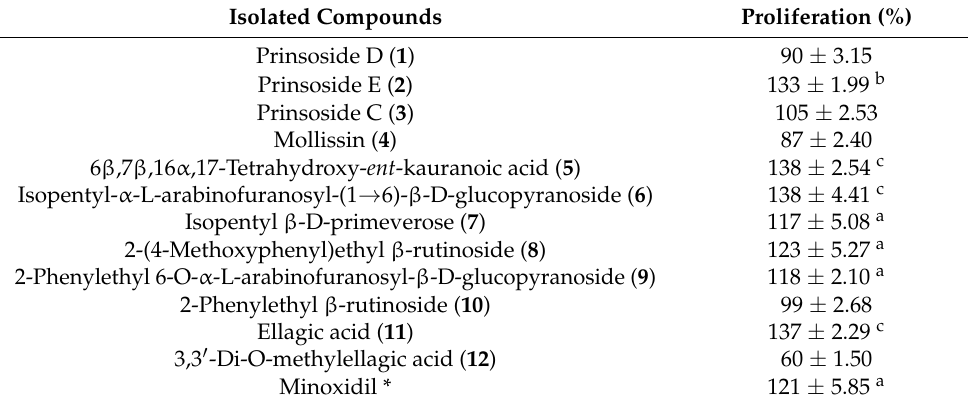
Table 3. Dermal papilla cell proliferation effect of isolated